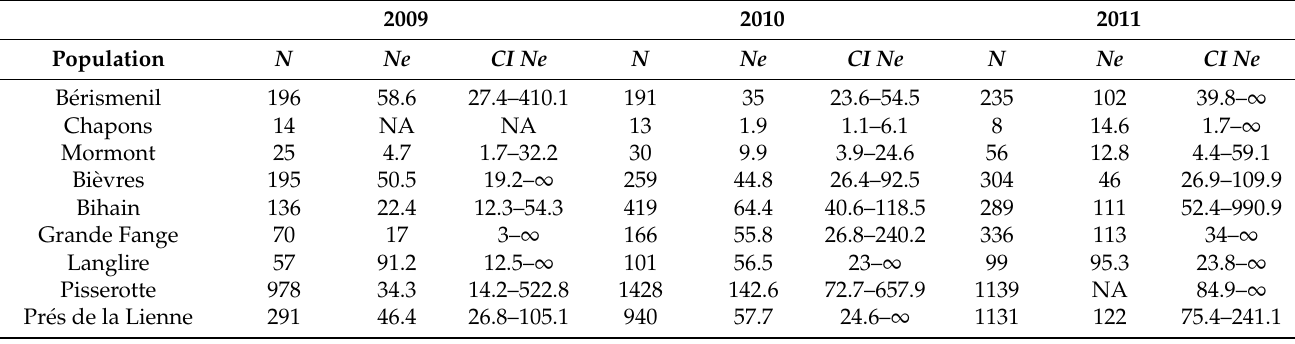
Table 1. Estimates of population sizes for each year of sampling. N = census population size recorded from Capture-Mark- Recapture data, Ne = effective population size inferred from microsatellite data analyzed with NeEstimator with their confidence intervals ( CI Ne ).